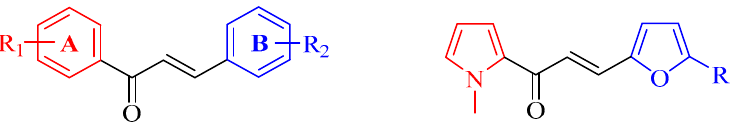
Figure 1. The design of new chalcone derivatives through the replacement of aryl rings ( A and B